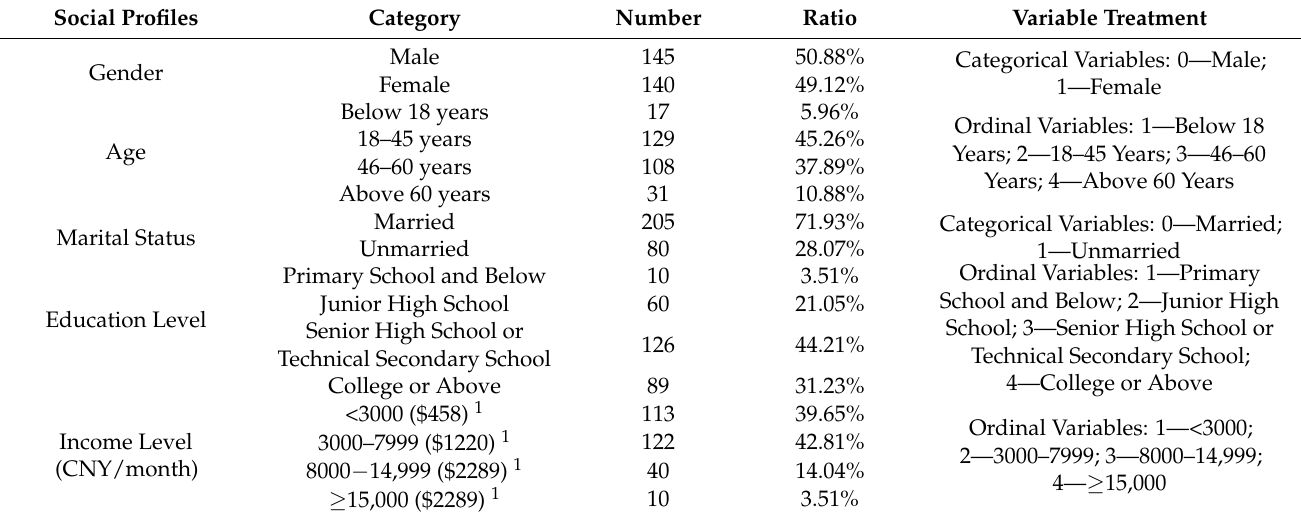
Table 3. Description of the respondents’ social